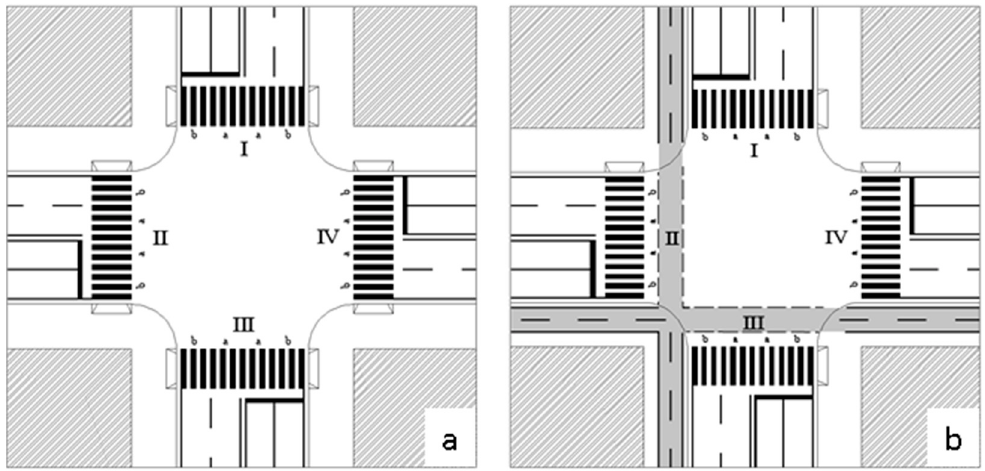
Figure 1. Study schemes ( a ) four-arm junction without bike path; ( b ) four-arm junction with bike path.